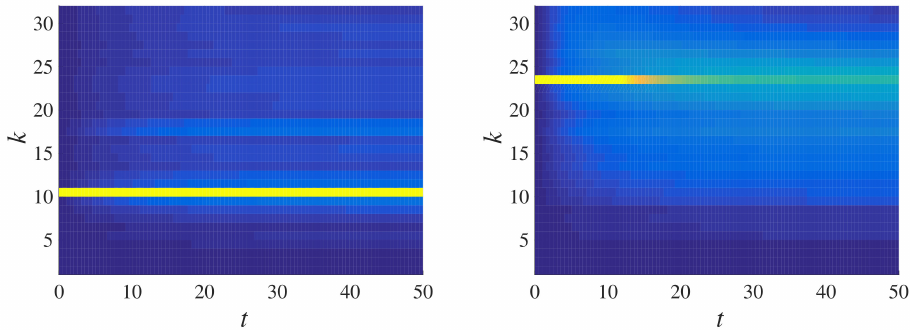
Figure 18. Frequency propagation of the ( a ) 10th and ( b ) 23rd bins computed using the Q matrix from Figure 17d, for ξ = 0.3, in Equation (51) with t max =